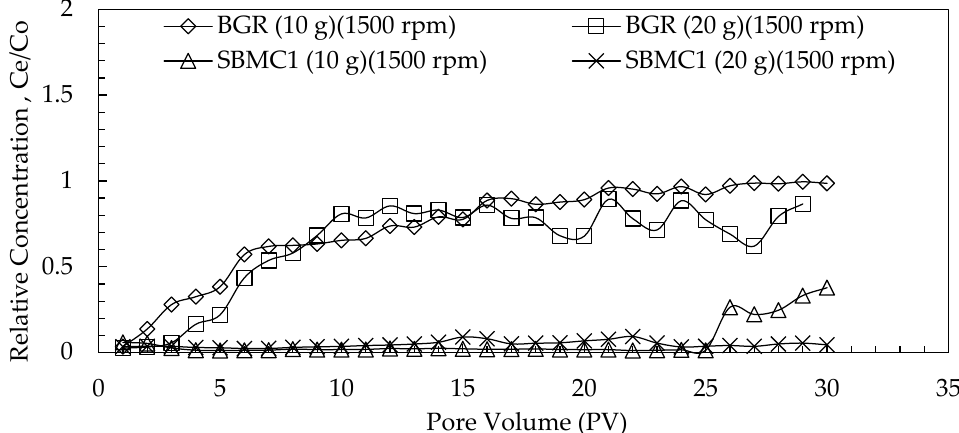
Figure 7. The effect of different g-forces on the migration of Cd in soil column. Note: 1500 rpm (520 × g ) and 2500 rpm (1440 × g ).